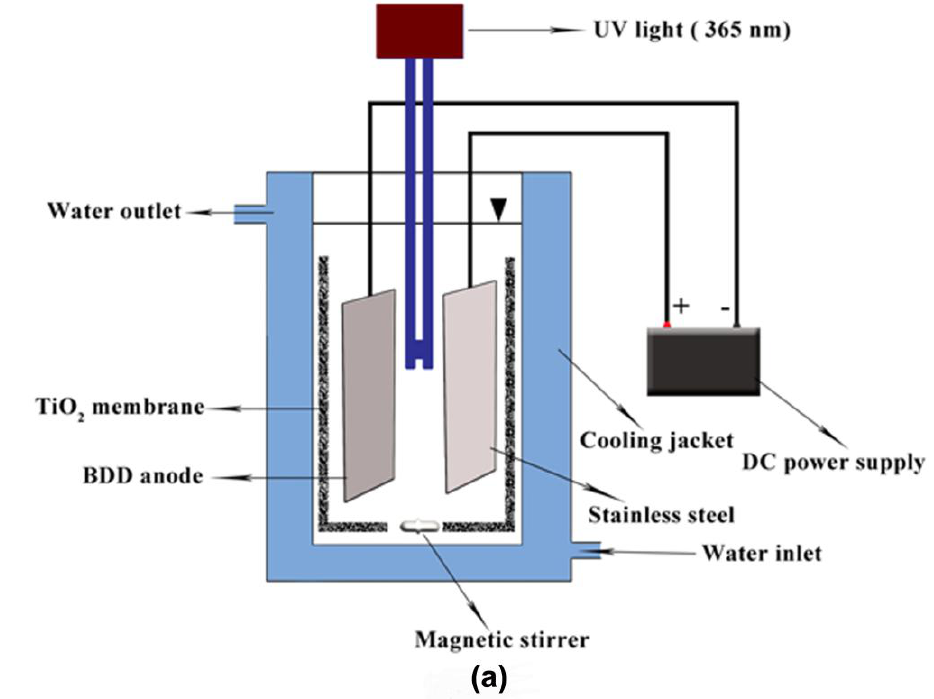
( b ) comparison of degradation performance in different experimental systems